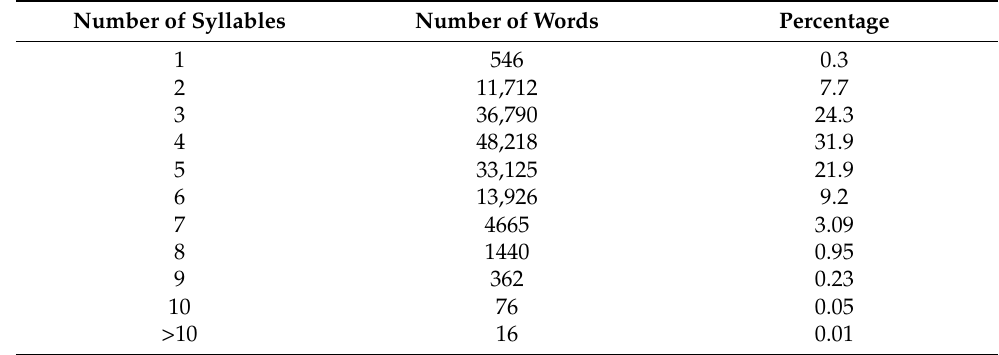
Table 1. Distribution of Brazilian Portuguese words according to number of syllables, according to REF